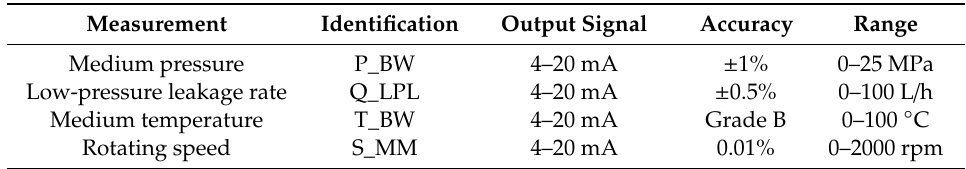
Table 2. Measuring